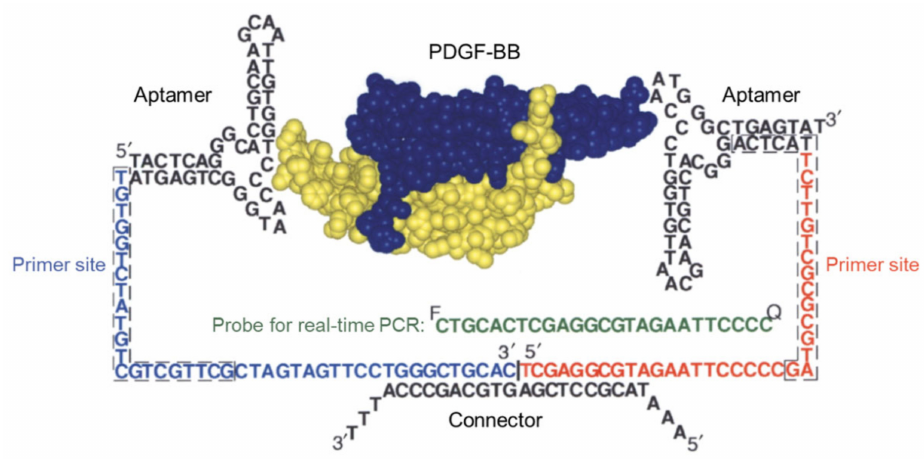
Figure 2. Structure and conceptual scheme of proximity ligation assay (PLA) for the detection of PDGF-BB. Reprinted by permission from Springer Nature Ltd.: Nat. Biotechnol. 2002, 20, 473–477, doi:10.1038/nbt0502-473. Copyright (2002)